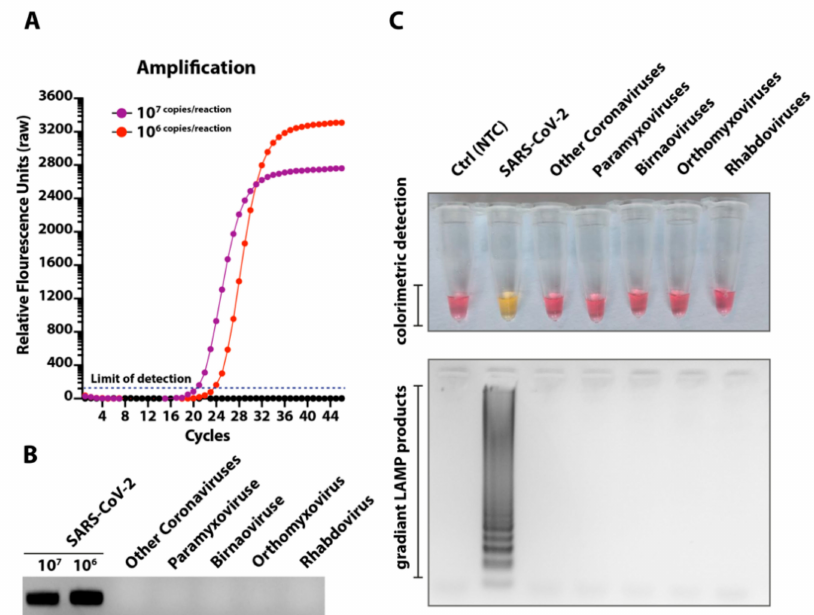
Figure 3. Specificity of the LAMP assay. ( A ) RNA extracted from di ff erent medically or respiratory important viruses as well as two dilutions of synthetic RNA were run for qPCR. ( B ) Corresponding PCR products were run on gel to demonstrate specificity. ( C ) Similar to qRT-PCR, extracted RNA were run in the LAMP assays. The top panel indicates the colorimetric detection of LAMP positive / negative reactions and the lower panel shows the electrophoresis of the corresponding LAMP